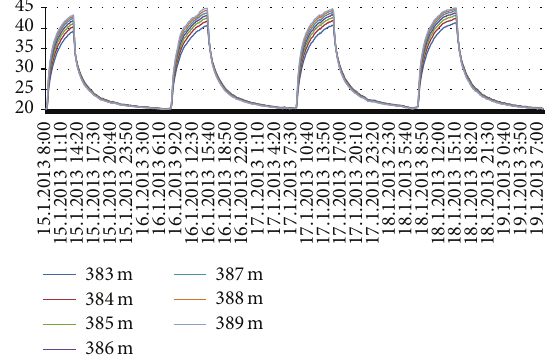
Figure 9: Heating-cooling cycles for gravel.